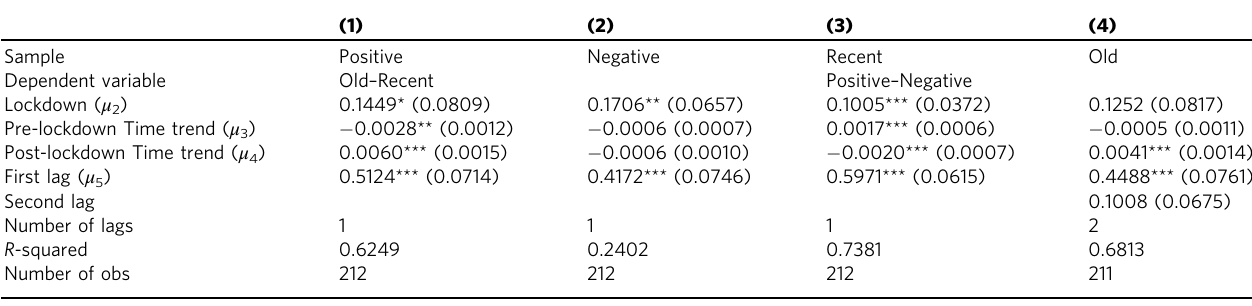
Table 4 Time series analysis of the preference for